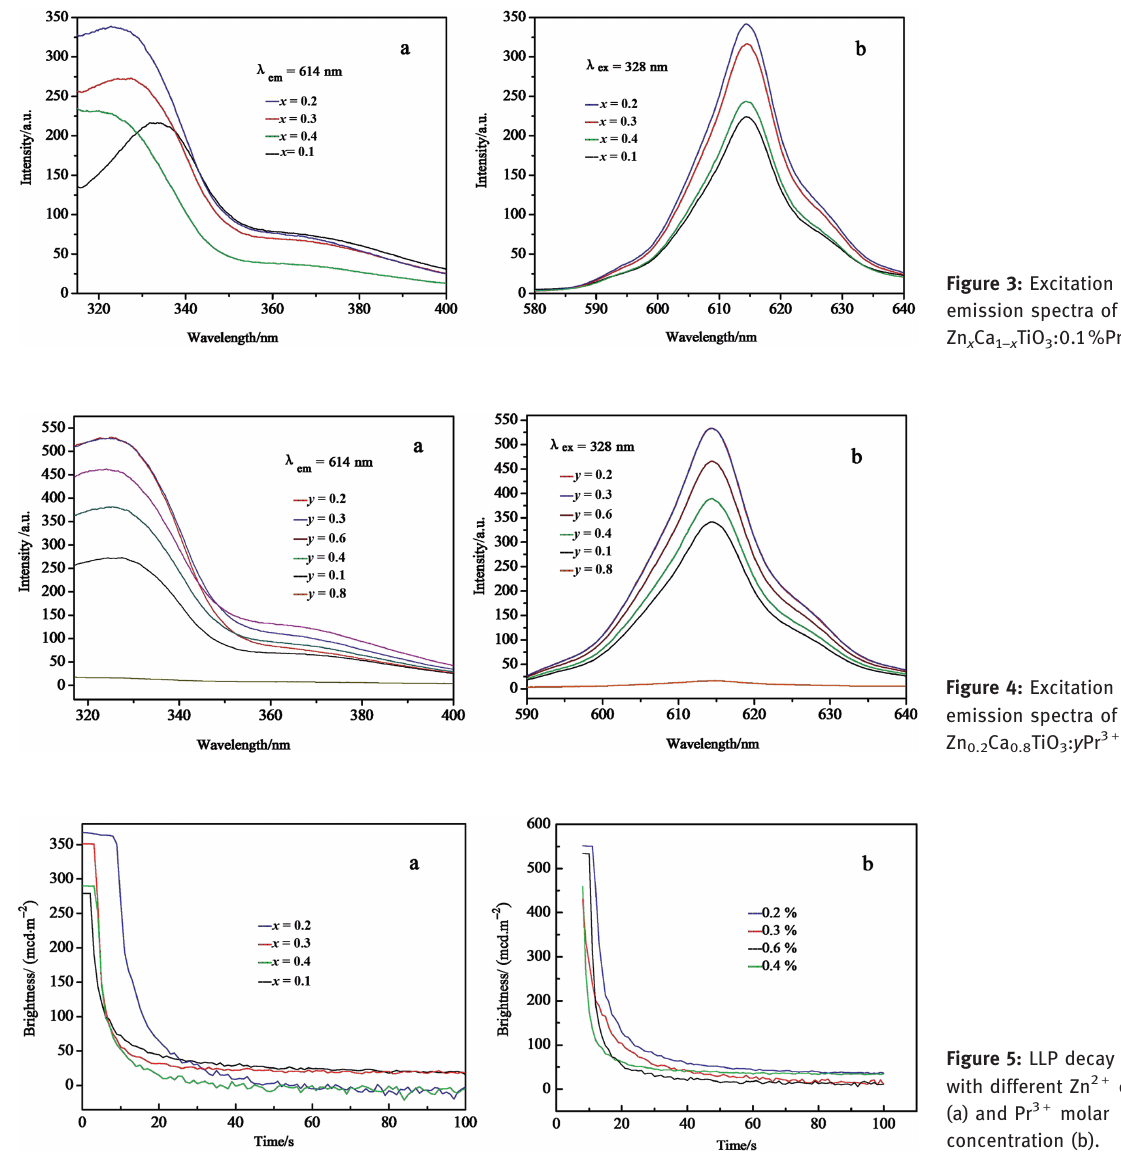
Figure 5: LLP decay curves with different Zn 2 + content (a) and Pr 3 + molar concentration